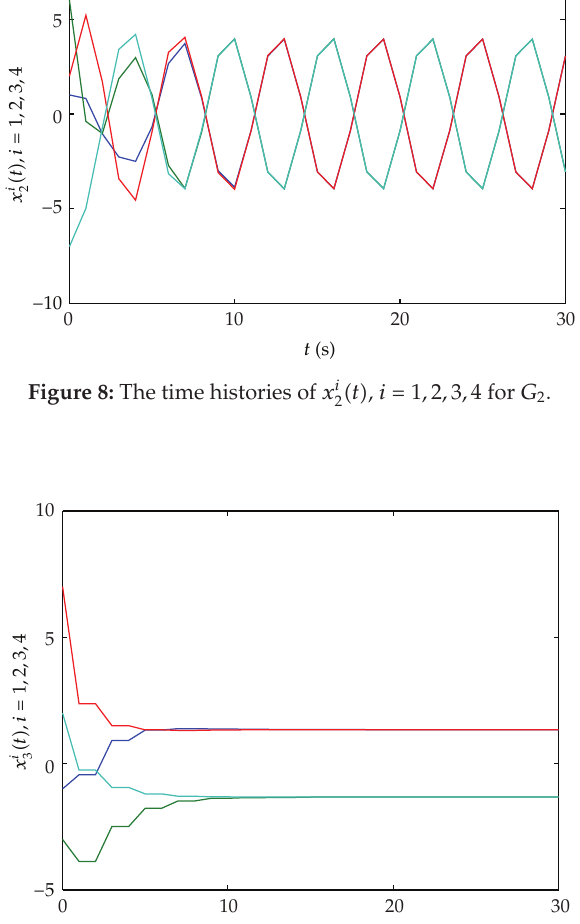
Figure 9: The time histories of x i